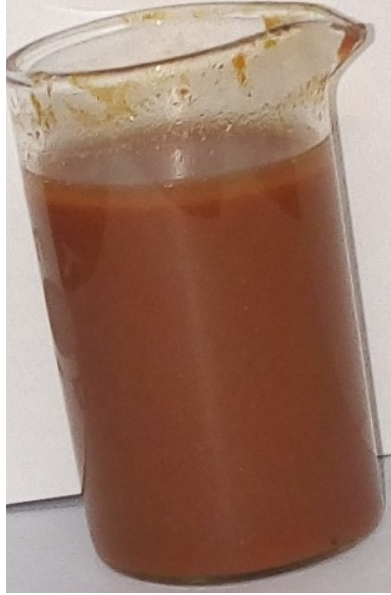
Figure 1. Suspension of GO in